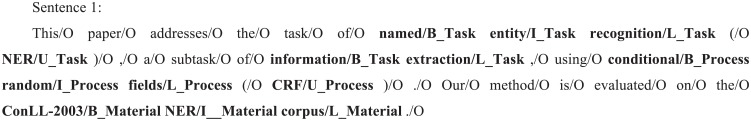
One example using the BILUO label scheme.Sentence 1 comes from the ScienceIE corpus.